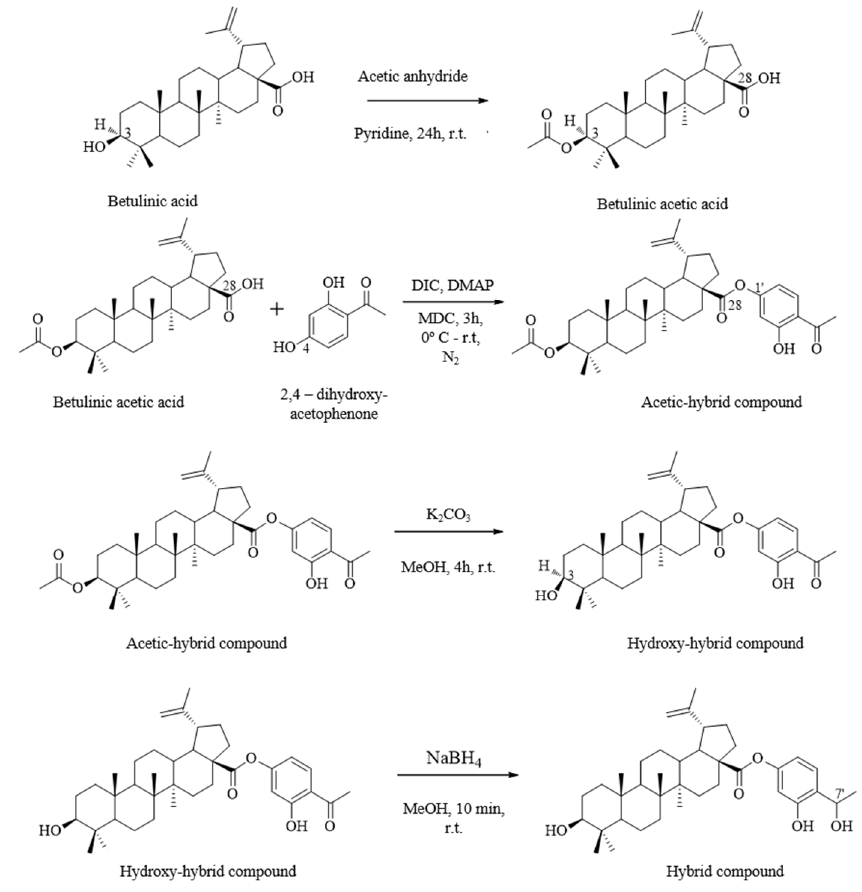
Figure 10. Illustrative scheme of hybrids synthesis from their natural precursors.